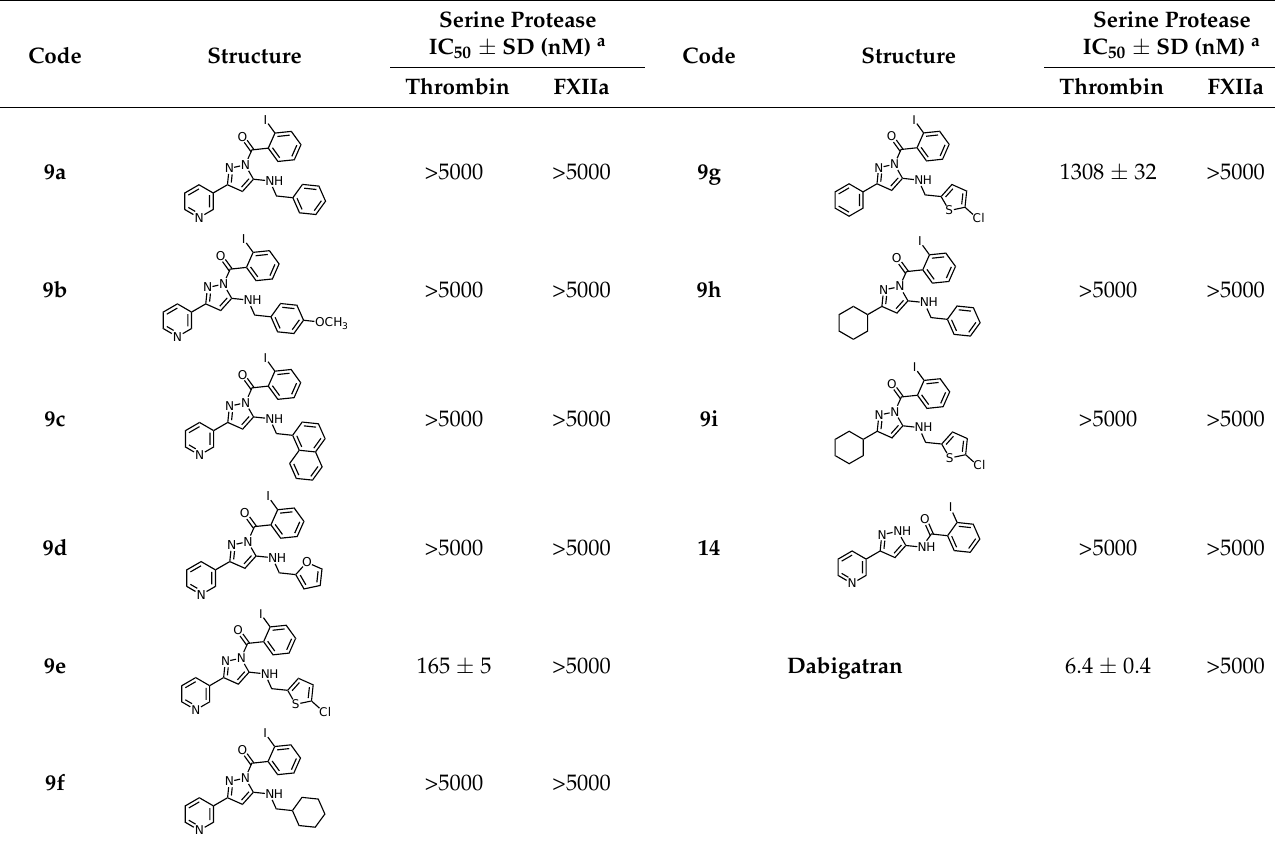
properties of a series of noncyclic acylated aminopyrazoles 9a - i and compound 14 (Table 2) as they share structural similarity with the lead compound 3 . Table 2. Thrombin and FXIIa Inhibition by Acylated Aminopyrazoles 9a – i and 14 . Table 2. Thrombin and FXIIa Inhibition by Acylated Aminopyrazoles 9a – i and 14 . Table 2. Thrombin and FXIIa Inhibition by Acylated Aminopyrazoles 9a – i and 14 . Table 2. Thrombin and FXIIa Inhibition by Acylated Aminopyrazoles 9a – i and 14 . Table 2. Thrombin and FXIIa Inhibition by Acylated Aminopyrazoles 9a – i and 14 . Table 2. Thrombin and FXIIa Inhibition by Acylated Aminopyrazoles 9a – i and 14 . Table 2. Thrombin and FXIIa Inhibition by Acylated Aminopyrazoles 9a – i and 14 . Table 2. Thrombin and FXIIa Inhibition by Acylated Aminopyrazoles 9a – i and 14 . Table 2. Thrombin and FXIIa Inhibition by Acylated Aminopyrazoles 9a – i and 14 . Table 2. Thrombin and FXIIa Inhibition by Acylated Aminopyrazoles 9a – i and 14 . Table 2. Thrombin and FXIIa Inhibition by Acylated Aminopyrazoles 9a – i and 14